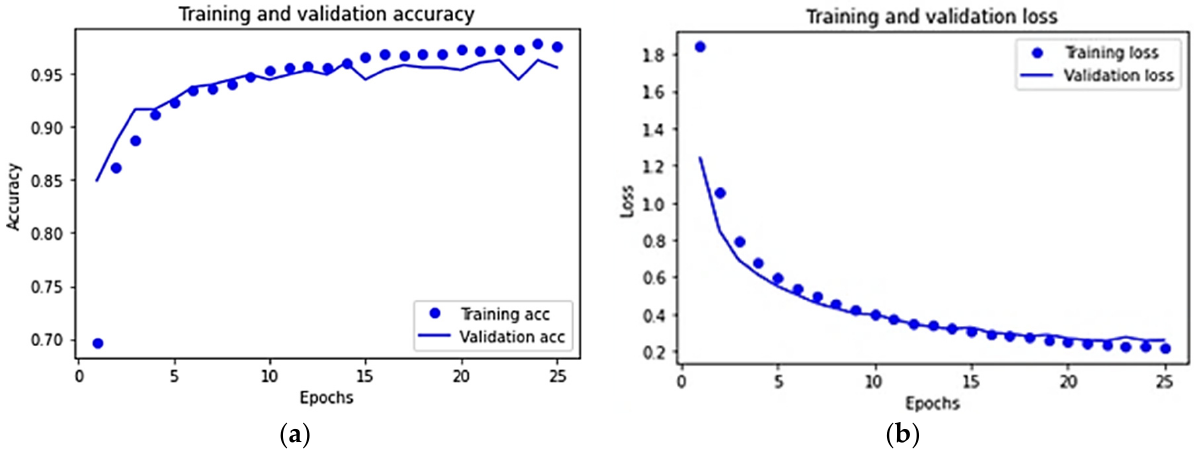
Figure 7. For the VGG16 pre-trained model: ( a ) training and validation accuracy, and ( b ) training and validation loss.